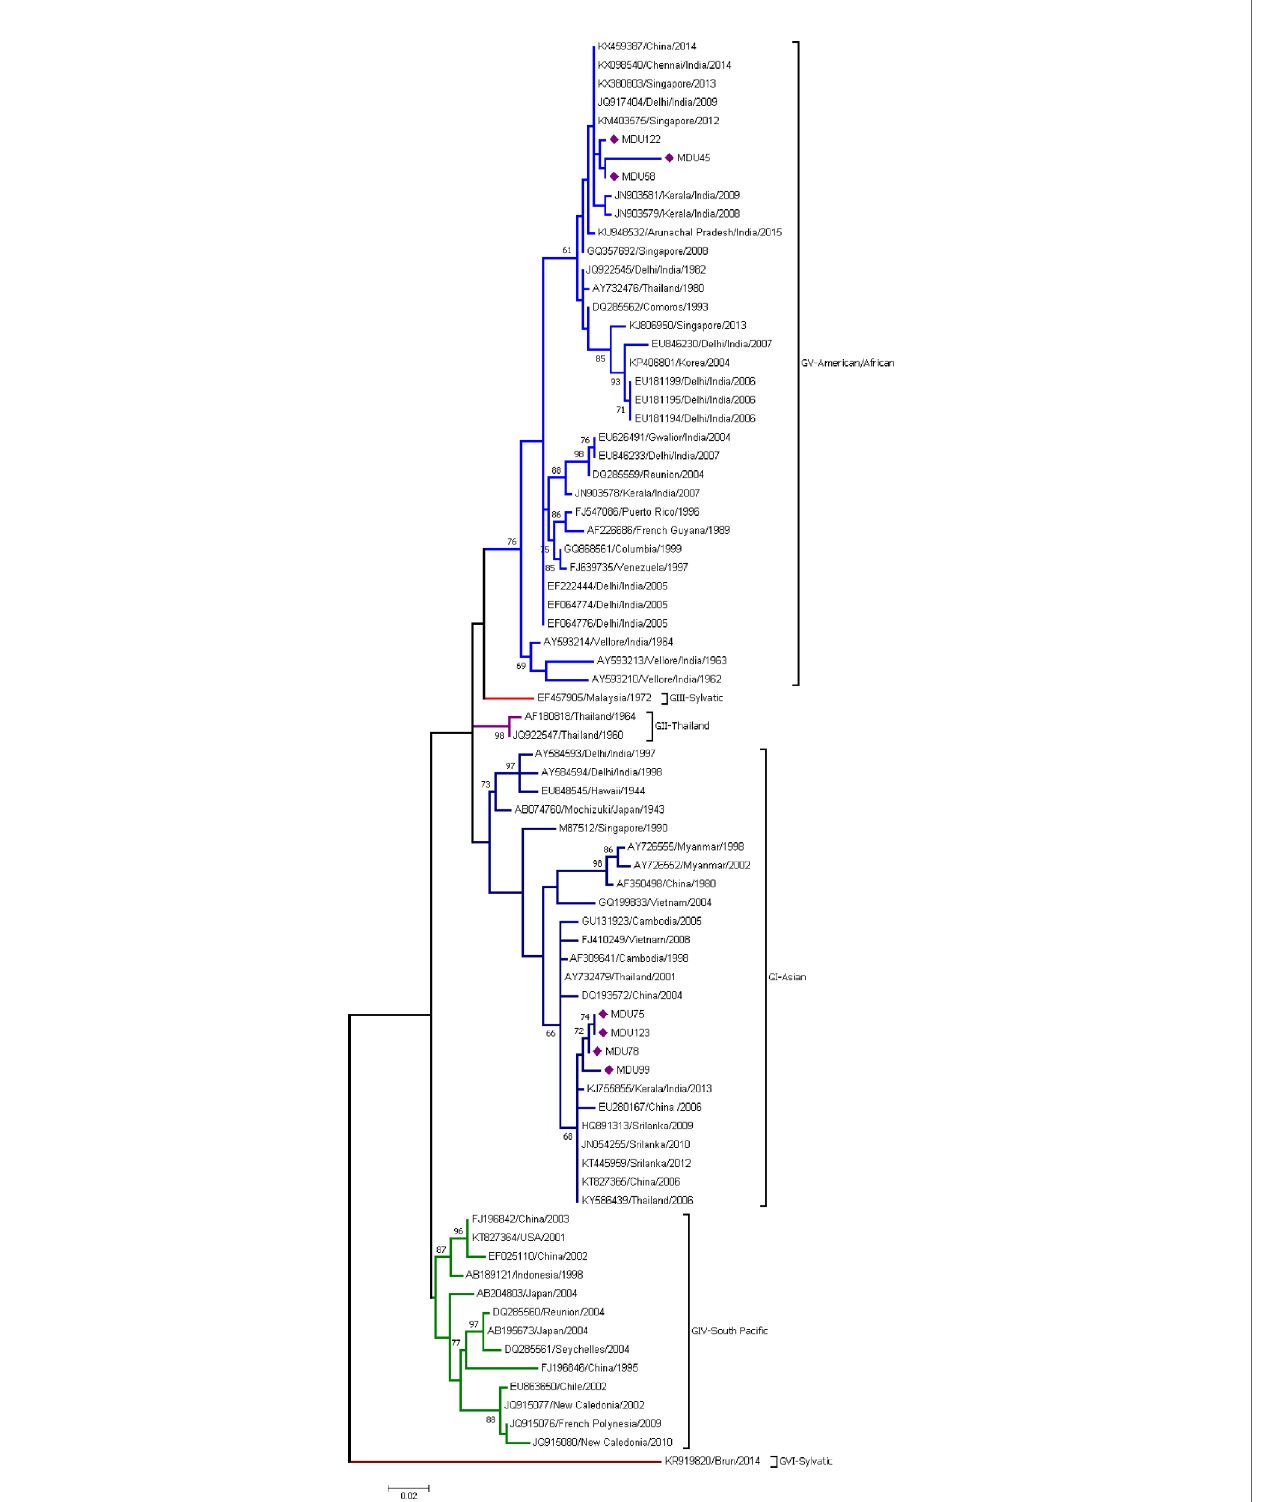
FIGURE 1 | Phylogeny of DENV-1. The phylogeny of DENV-1 was inferred by using the ML method. The tree with the highest log likelihood (-2,257.26) is shown. The analysis involved 77 nucleotide sequences. There was a total of 364 positions in the fi nal dataset. Among the seven sequences, three sequences (MDU122, MDU45, and MDU58) were grouped under genotype V (American/African), and the remaining four sequences (MDU75, MDU123, MDU78, and MDU99) were grouped with genotype I (Asian). Nucleic acid substitution per position was calculated as 0.02.